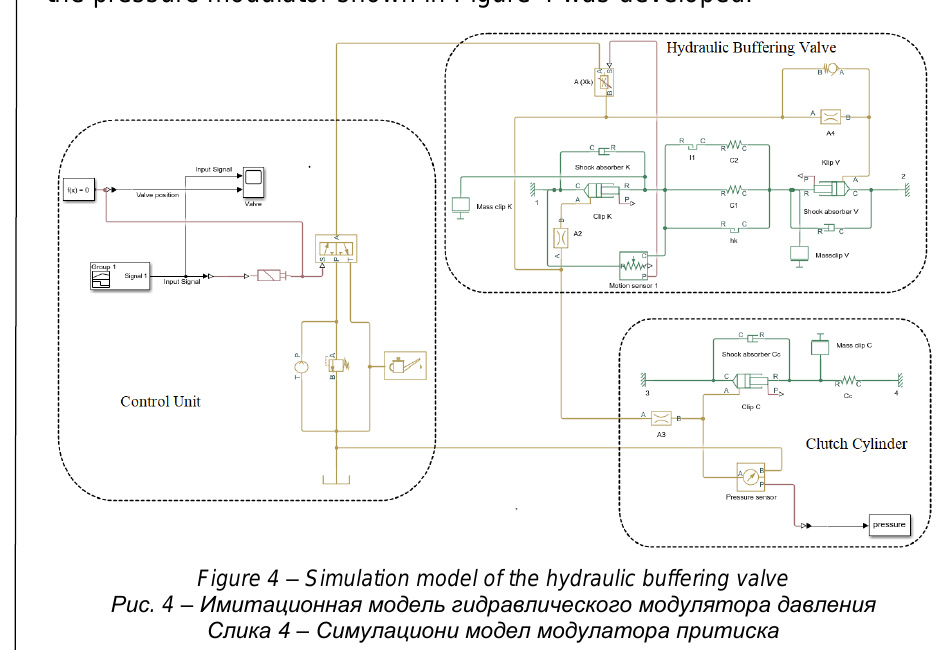
Figure 4 – Simulation model of the hydraulic buffering valve Рис. 4 – Имитационная модель гидравлического модулятора давления Слика 4 – Симулациони модел модулатора